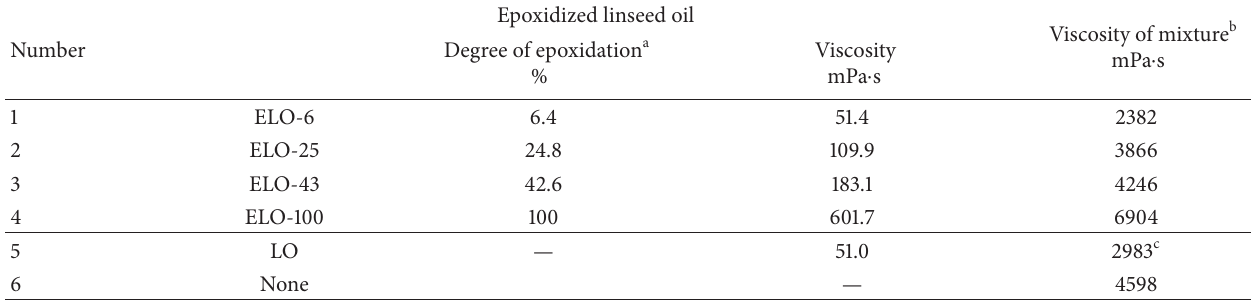
Table 1: Viscosity of kurome lacquer paint with epoxidized linseed oil.